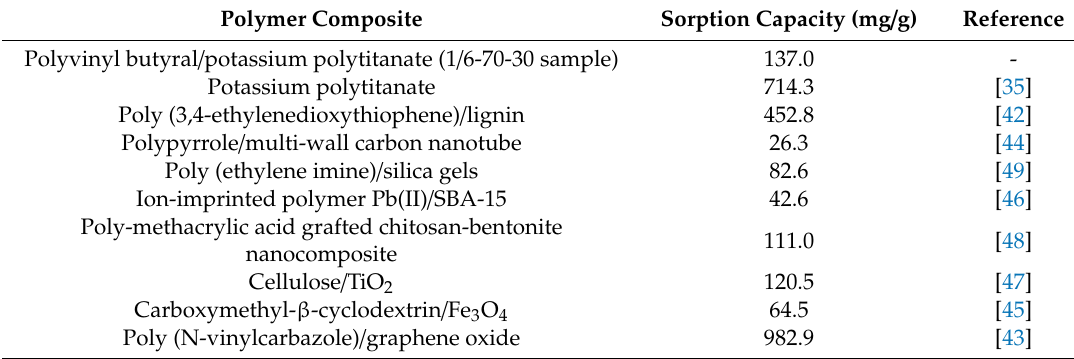
Table 2. The sorption capacity of di ff erent polymer matrix composites with respect to lead ions. Polymer